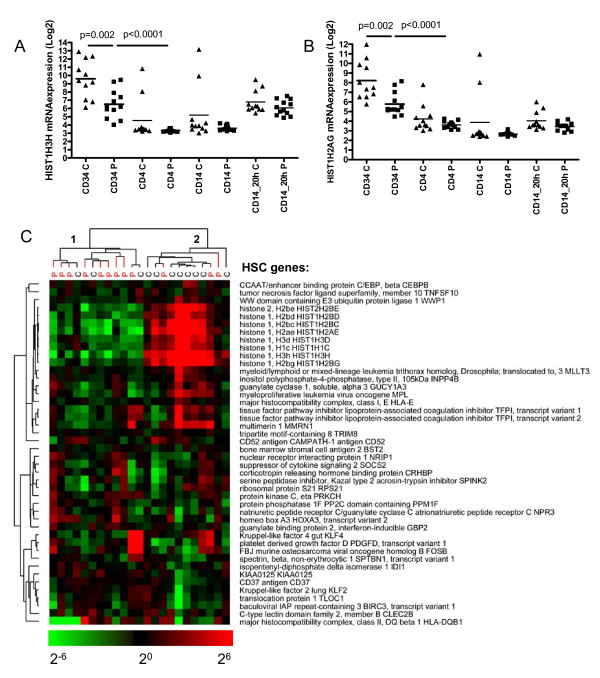
CD34+ cells from CAD patients are less primitive. Histone gene expression is decreased in CD34+ cells from CAD patients. mRNA expression levels are shown of two representative histone genes, HIST1H3H (A) and HIST1H2AG (B) in all studied cell types in CAD patients (squares) and controls (triangles). C: Several histone genes belong to the more "primitive" HSC genes [15] and are expressed at lower levels in CD34+ cells from CAD patients.